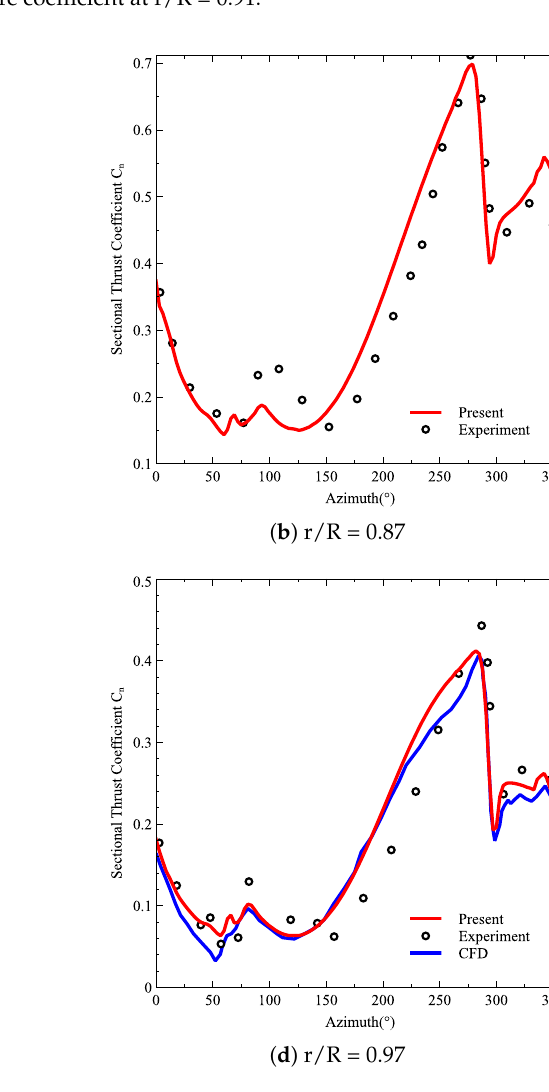
Figure 12. Sectional thrust for the AH-1G rotor at different radial